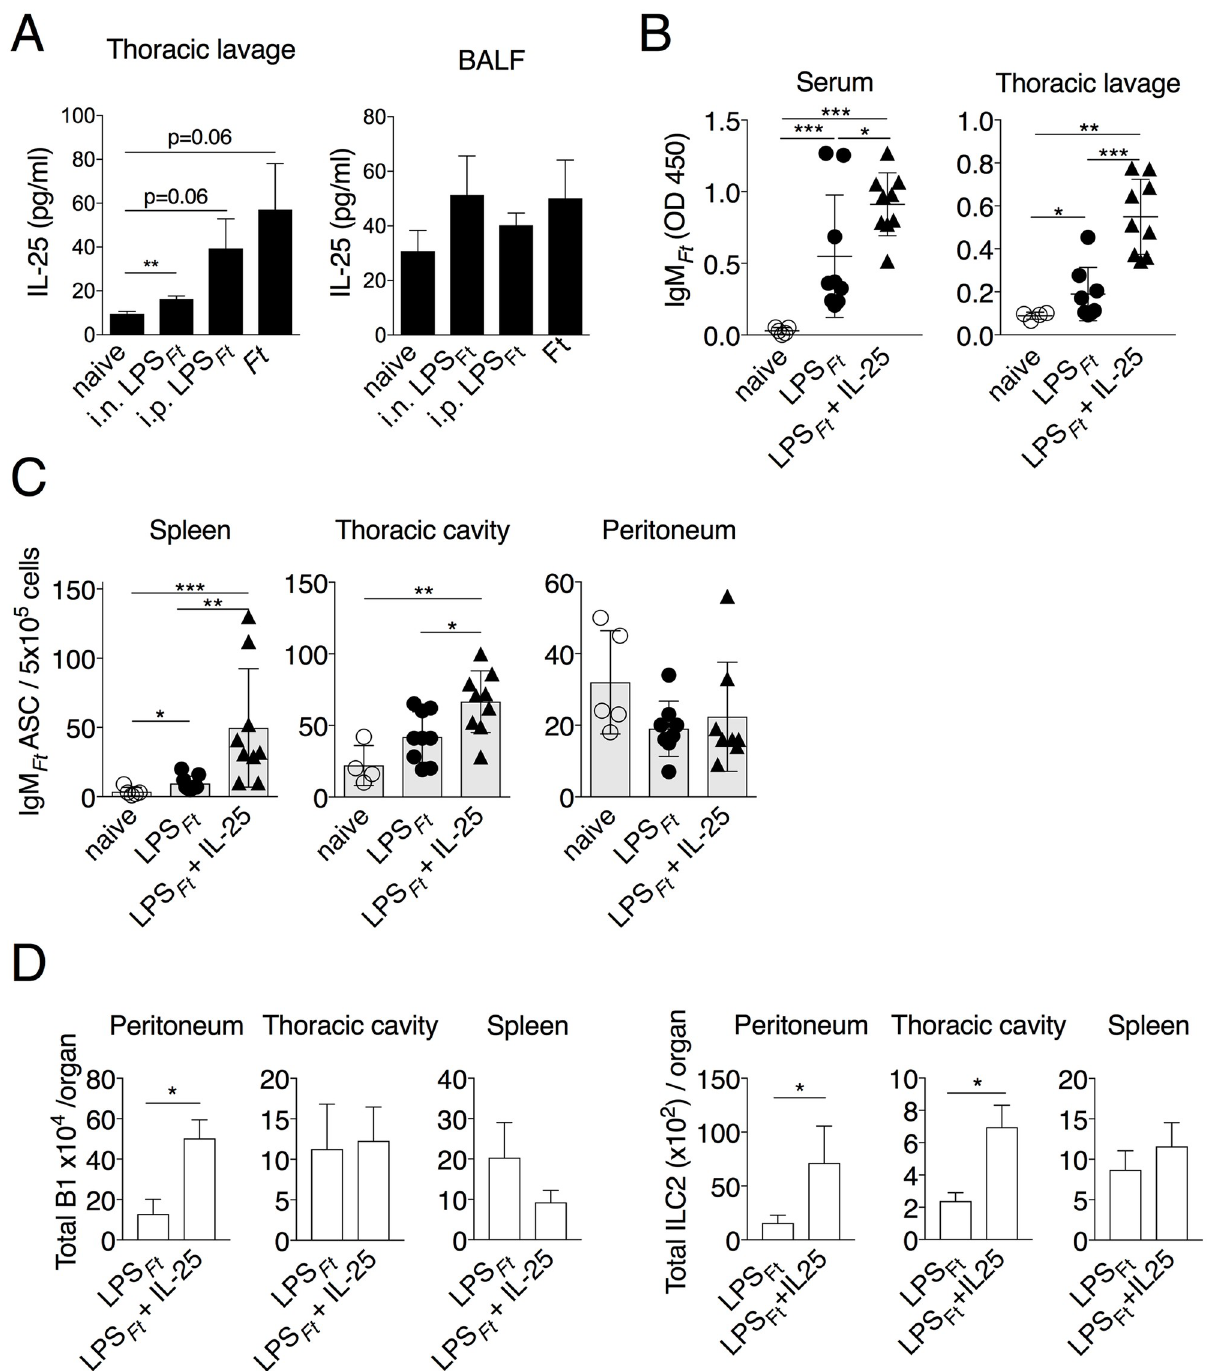
Fig 5. IL-25 enhances production of IgM . (A) IL-25 was measured in BALF or thoracic cavity lavage 18 hrs post immunization or infection in WT Ft B6 mice (n = 3). (B, C) WT B6 mice were treated with recombinant IL-25 and immunized i.n. with LPS Ft . Seven days p.i. IgM Ft was measured in serum or thoracic cavity lavage and IgM ASC were enumerated by ELISPOT. (D) Total number of B1 and ILC2 cells. One representative experiment of two Ft (A) or three (B, C) is shown. Data are expressed as mean ± SD. A, unpaired students t test; B-D, Mann-Whitney U test. � p < 0.05, �� p < 0.01, ��� p < 0.001. See also S5